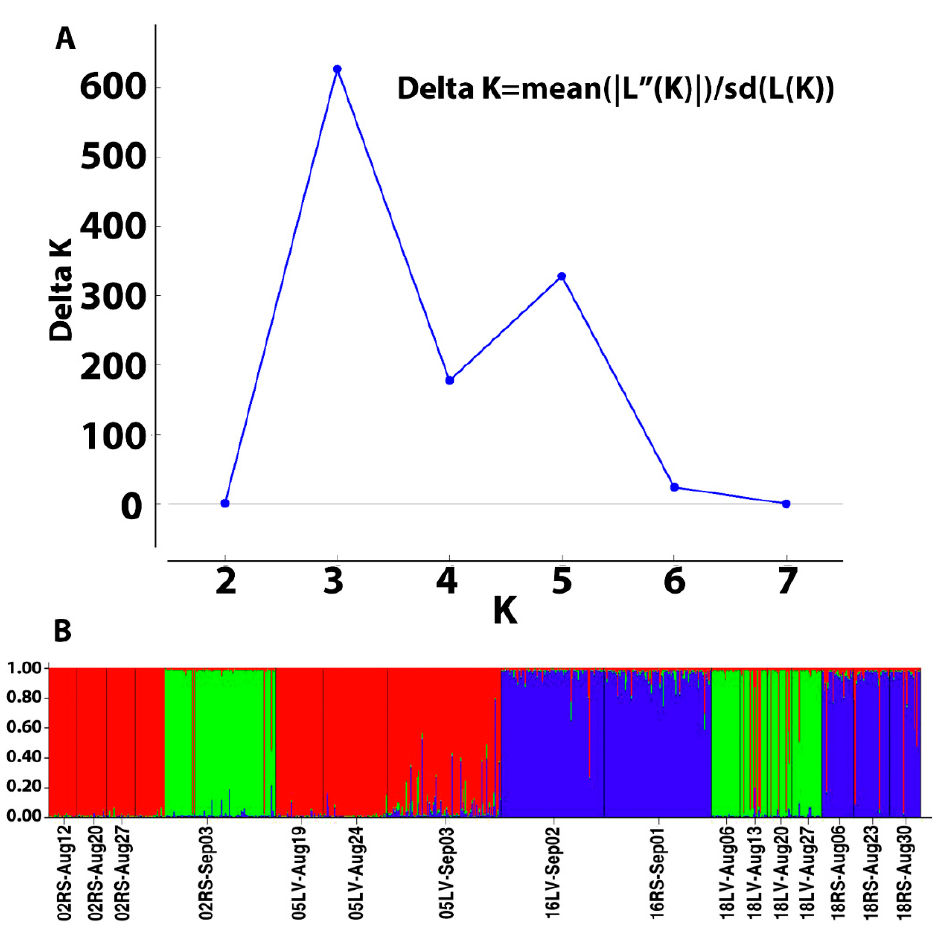
Figure 4. The plot of ∆ K for successive population cluster number (K) generated using the Evanno method [50] implemented in the Structure Harvester web application ( A ), and the bar plot generated using population assignments in one of the STRUCTURE [49] simulations at K = 3 ( B ). Putative population names are marked on the X-axis.